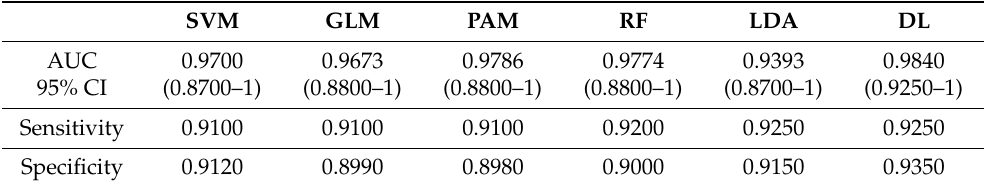
Table 2. Artificial Intelligence and circulating cfDNA prediction for the Alzheimer’s disease intragenic CpGs (20 Variables Cross Validation–Independent Test